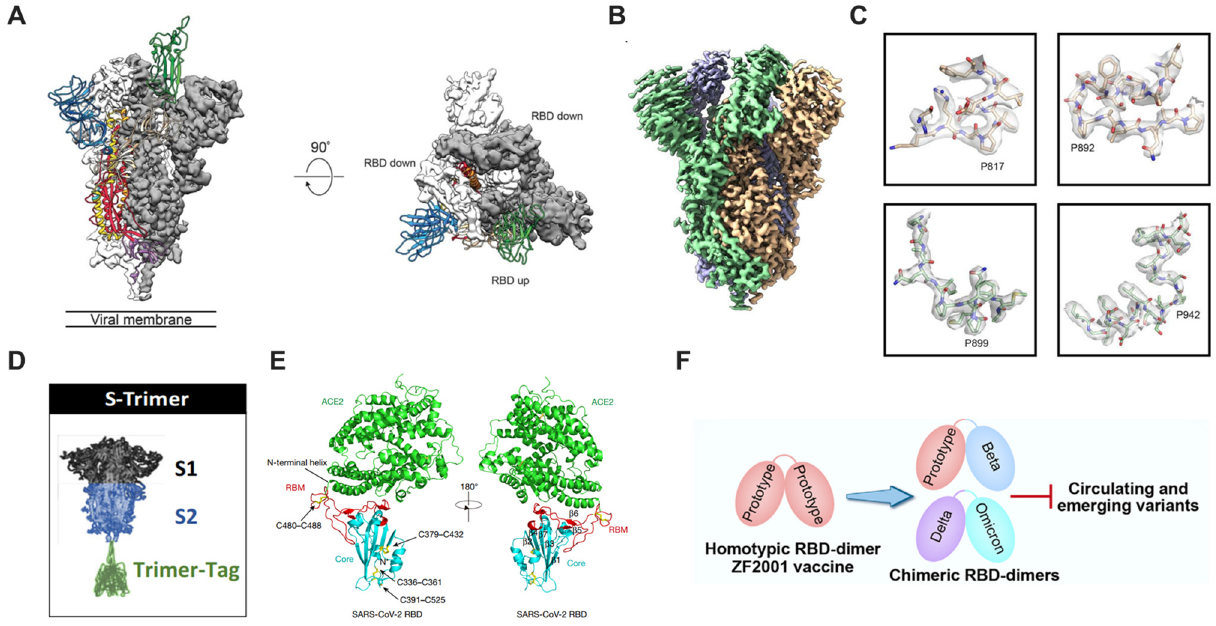
Figure 2. Structure-guided vaccine design. ( A ) Structure of SARS-CoV-2 spike protein in the prefusion conformation. The "up" conformation is the receptor-accessible state, and the "down" conformation corresponds to the receptor-inaccessible state. Reproduced with permission from Ref. [56]. Copyright